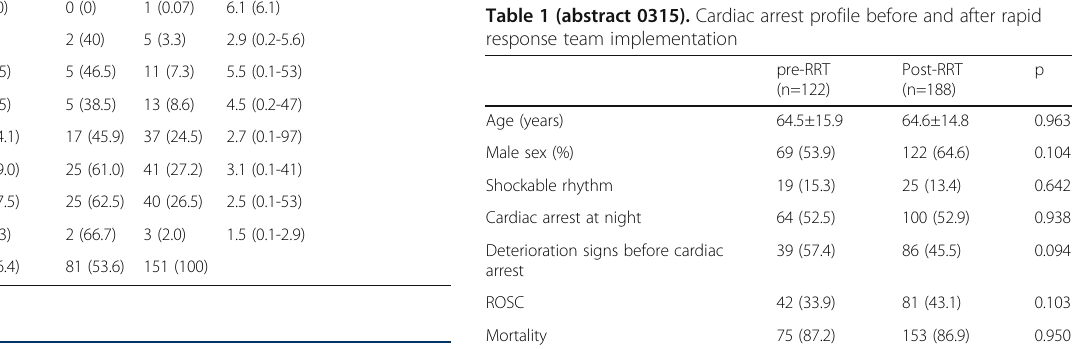
Table 1 (abstract 0314). Breakdown of patients being discharged back to the ward post in-hospital cardiac arrest Age Range Survived (%) Died (%) Total (%) Median # of days in ICU (range)